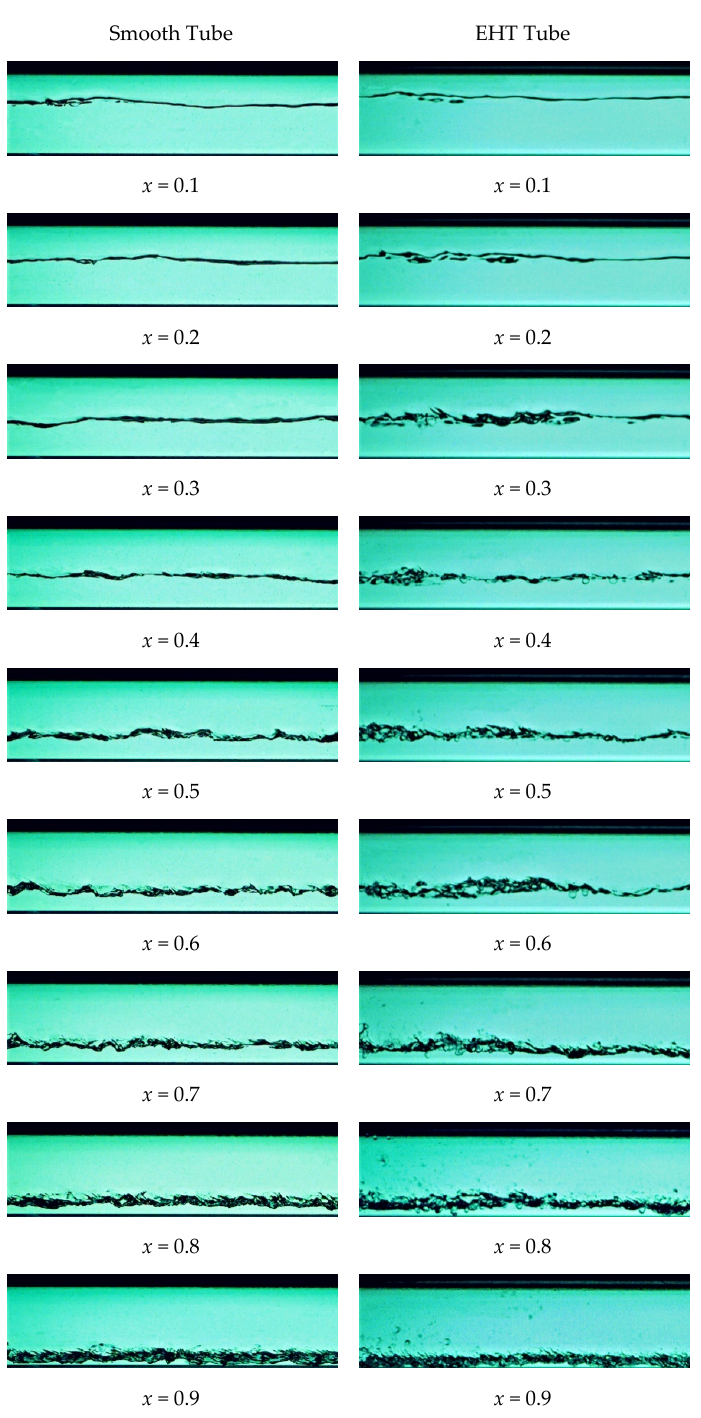
Figure 8. Condensation flow patterns inside a smooth tube and an EHT tube. Cabot and Cook [14] show snapshots of density field evolution from DNS of RTI in the fully turbulent regime. The heavy fluid is red, the light fluid is blue, and the mixed fluid is green. The flows are initialized with a stationary interface between the high and low-density fluids, whose vertical position is perturbed with potential fluctuations having